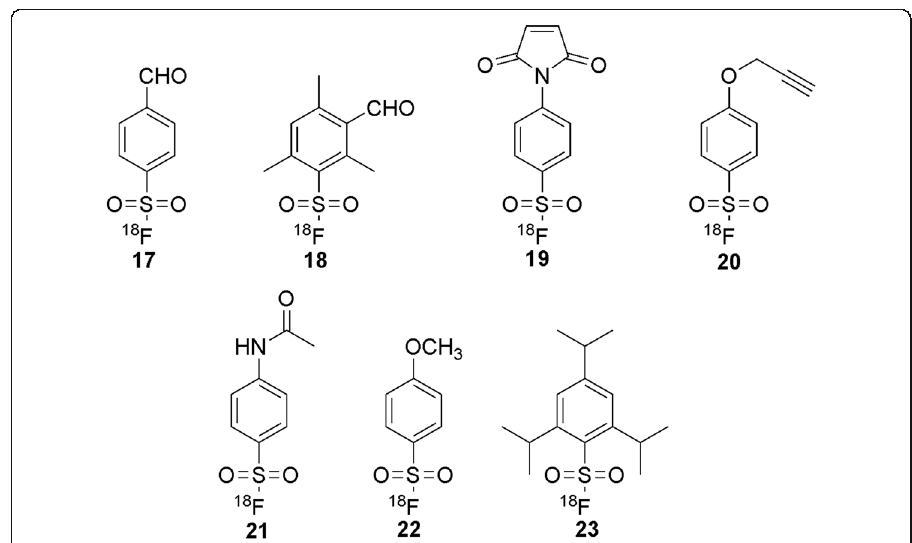
Fig. 5 Selected aryl [ 18 F]sulfonyl